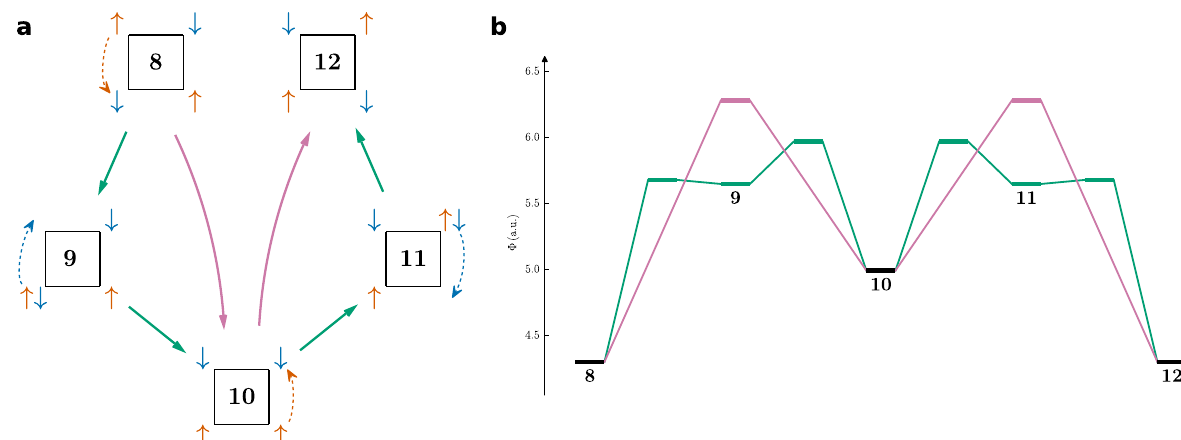
Fig. 6 Maximum probability paths for the π system of singlet CBD. Without restrictions (green) and restricted to covalent DCPs (purple). a Spin-up and spin-down electrons rotate in opposite directions. b Probabilistic barriers.